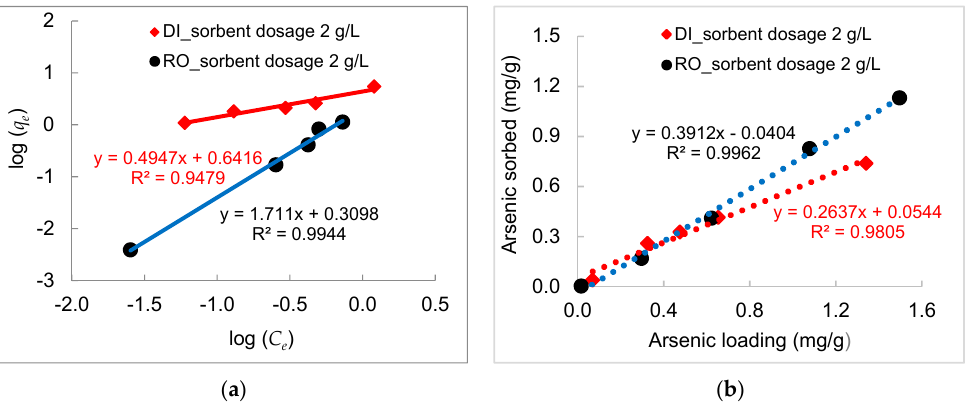
Figure 4. Effect of initial arsenic concentration in RO concentrate and deionized water at low sorbent dosage (2 g/L) with pH 7 and 23 ◦ C. ( a ) Freundlich isotherm; ( b ) Amount of arsenic sorbed.